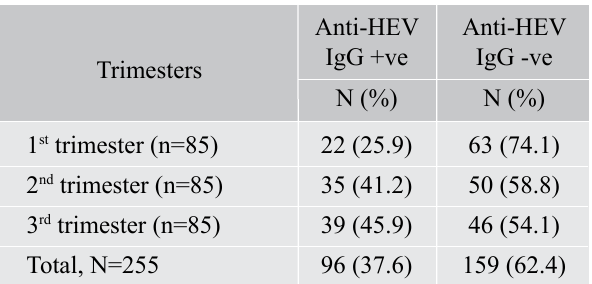
Table 1: HEV IgG seroprevalence on the basis of the stages of pregnancy